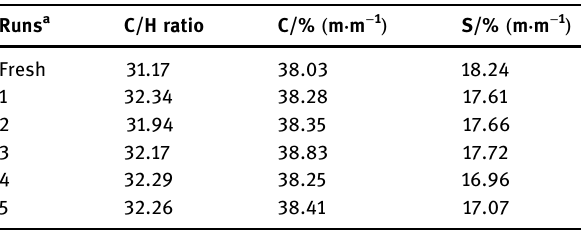
Table 3: Element analysis of the recycled catalysts Runs a C/H ratio